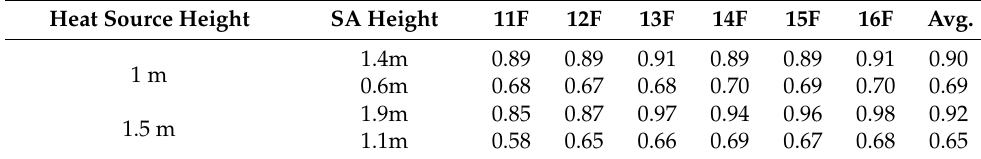
Table 12. PMV values with various SA